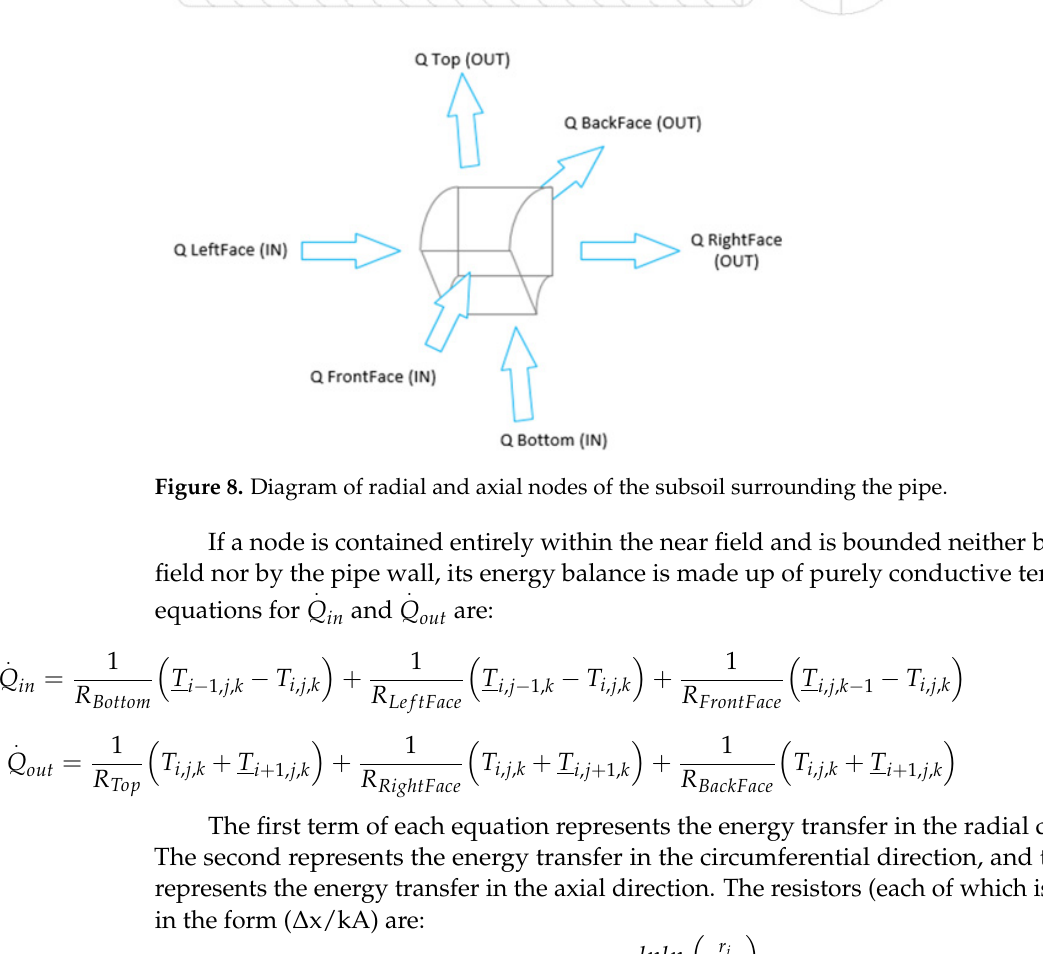
The first term of each equation represents the energy transfer in the radial direction. The second represents the energy transfer in the circumferential direction, and the third represents the energy transfer in the axial direction. The resistors (each of which is written in the form ( Δ x/kA) are: